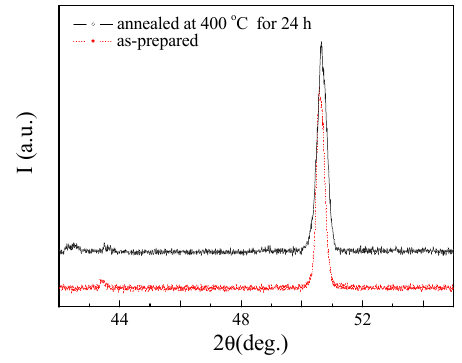
Figure 23. XRD patterns of as-prepared and annealed at 400 °C for 24 h Cu 90 Co 10 microwires. Then, we deduced considerable preferred orientation of the grains visible from the peak intensities. Usually the peaks at 2 θ ≈ 43.95° in Co-Cu granular alloys without texture present the highest intensity [82].